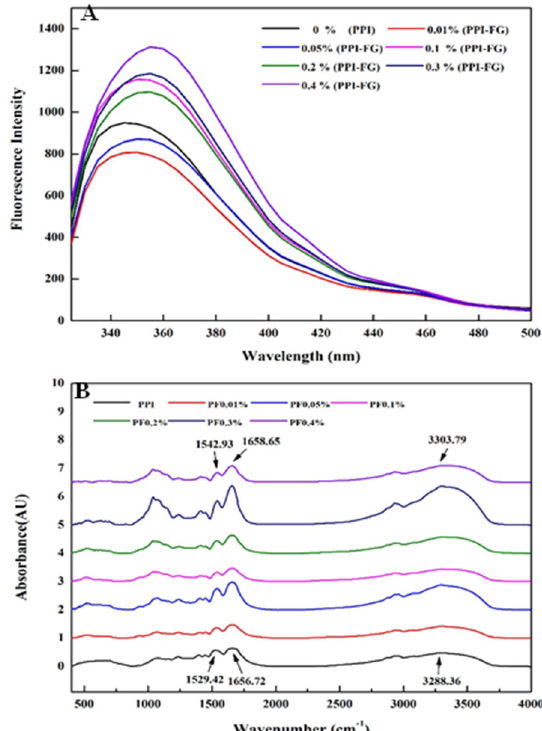
Figure 2. Spectroscopic analysis (PPI/FG solutions pH 5, FG = 0–0.4 wt.%); ( A ) fluorescence spectroscopy; ( B ) FTIR spectroscopy.